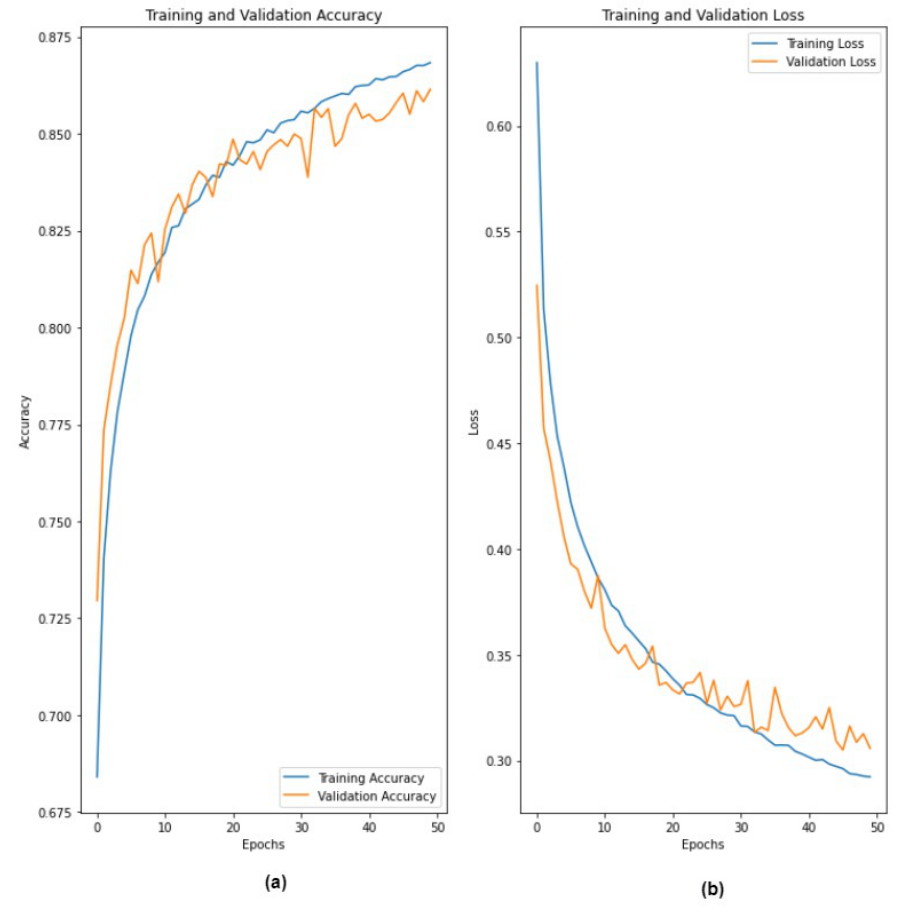
Figure 10. Performance graph of the proposed 2D-CNN model obtained from 10-fold cross validation